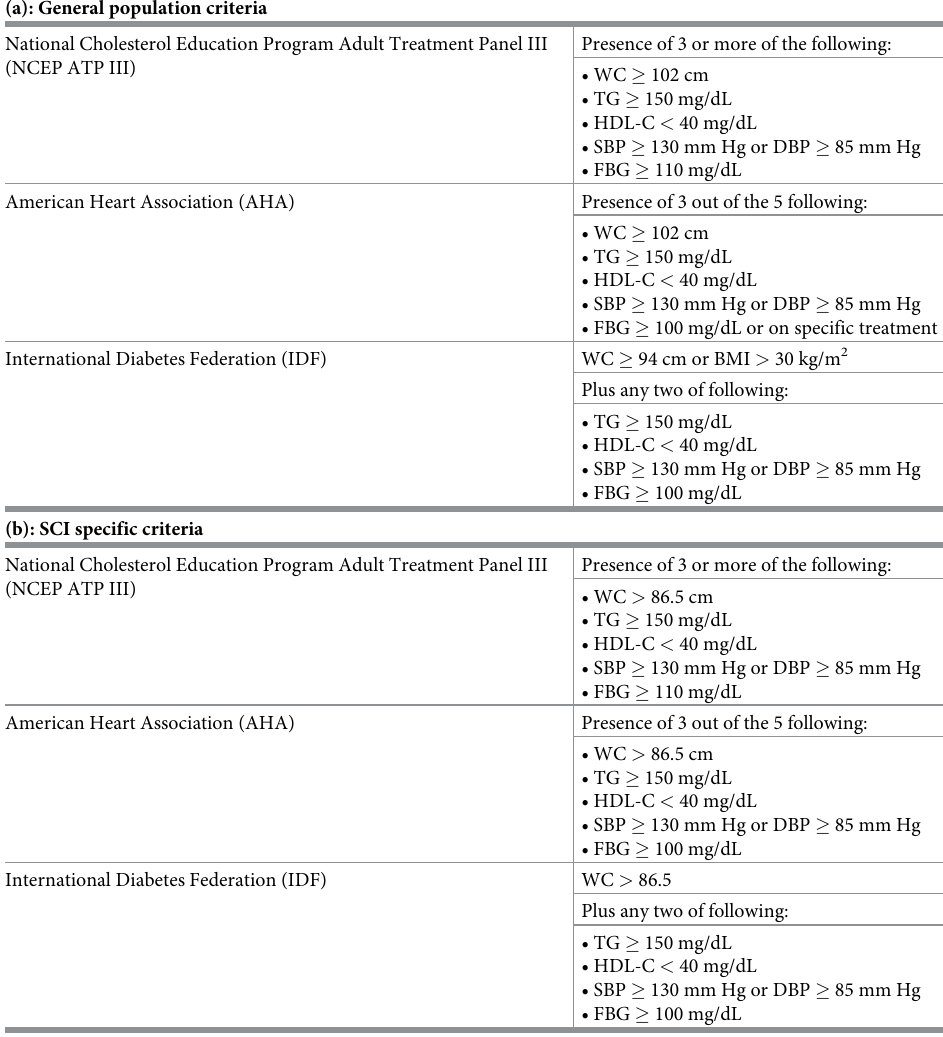
Table 1. Metabolic syndrome using three different definitions that apply waist circumference as primary